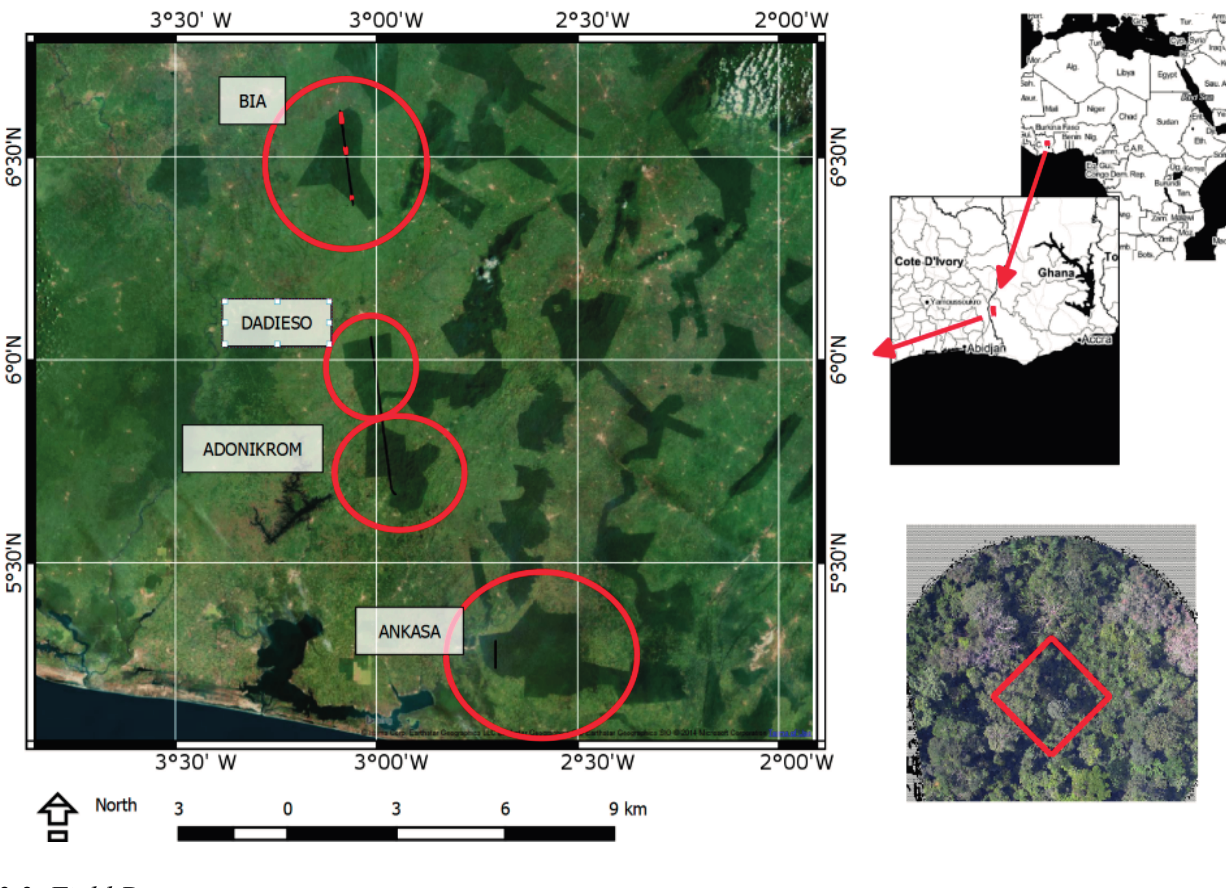
Figure 1. Study area identification at different